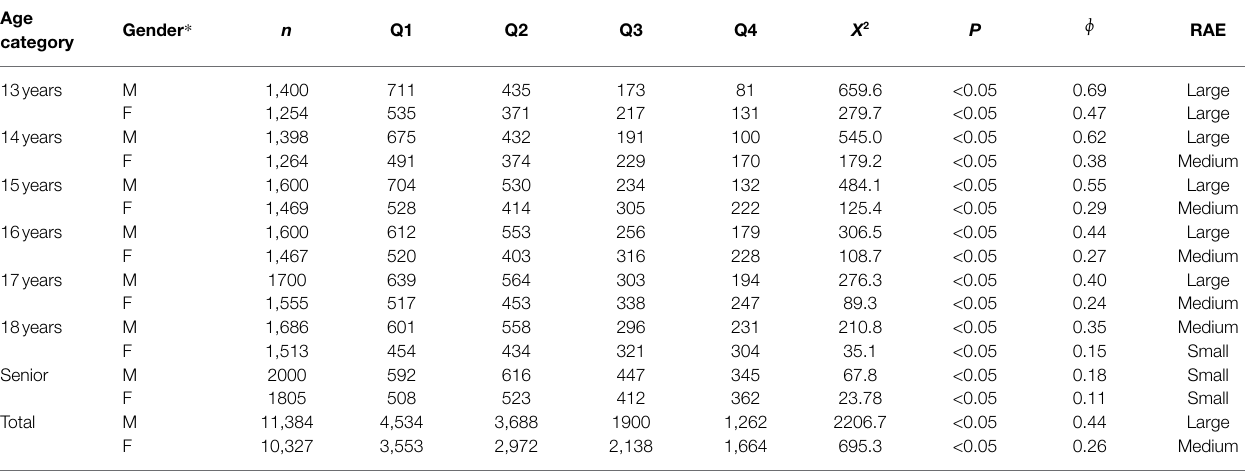
TABLE 1 | Prevalence of RAE among the all time best Norwegian track and field athletes, by age and gender ( N = 21,711). Age category